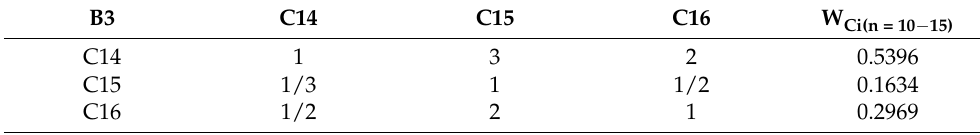
Table A4. B3-C i(i = 14 − 16) Judgment Matrix and Consistency Test.